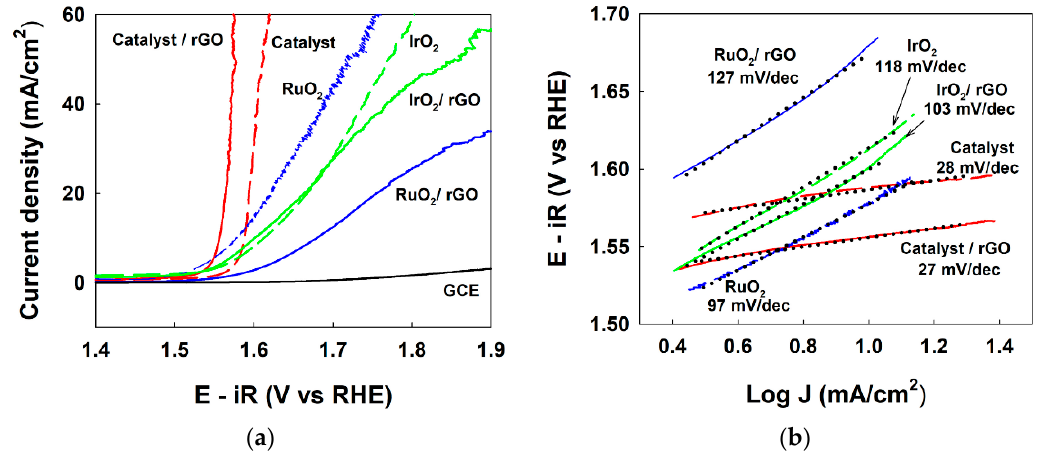
Figure 2. ( a ) LSV and ( b ) Tafel plots of the catalyst/rGO composite-modified (red solid), catalyst-modified (red dashed), RuO 2 /rGO composite-modified (blue solid), RuO 2 -modified (blue dashed), IrO 2 /rGO composite-modified (green solid), IuO 2 -modified (green dashed), and bare (black solid) GCEs in the OER. The O 2 -saturated 0.1 M KOH electrolyte solution was used. A scan rate of 50 mV/s and RDE rotation rate of 1600 rpm were used. All potentials were reported after IR compensation. Table 1. Overpotential, Tafel slope, and parameters corresponding to EIS response of electrocatalysts. Catalyst